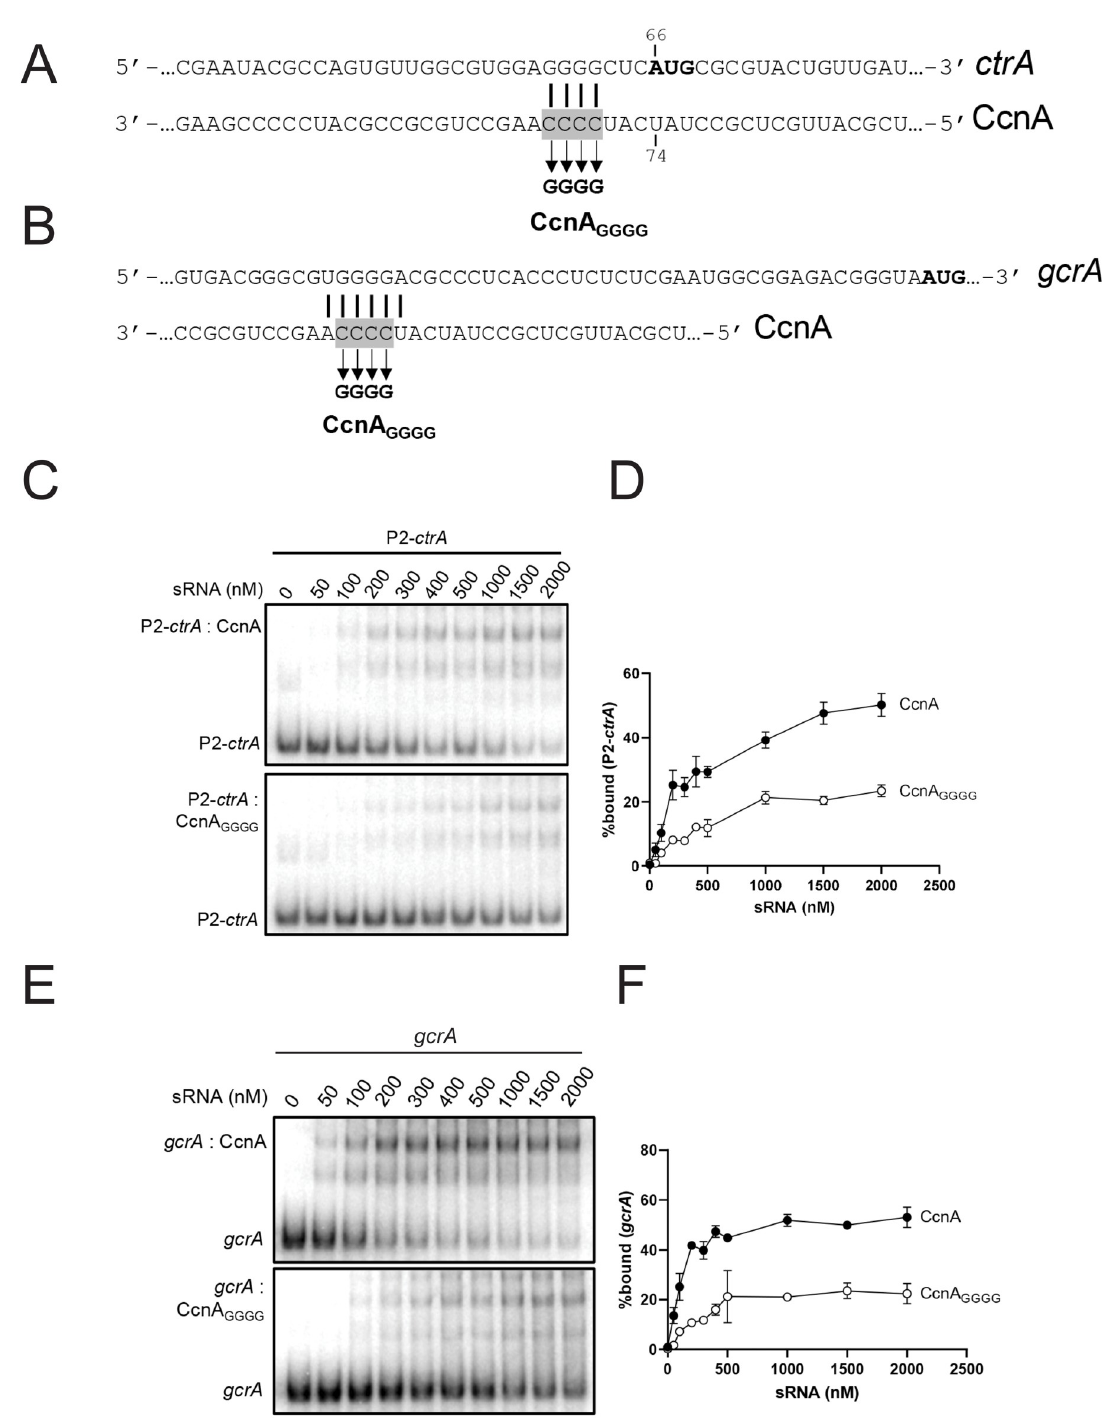
Fig 5. CcnA mutation of Loop A decreases the interaction with the 5 0 UTR of P2- ctrA mRNA and 5 0 UTR of gcrA mRNA. (A) Mutation of the ctrA mRNA ( ctrA ) and ncRNA CcnA (CcnA GGGG ) binding site (shown in red in Fig 4A). Solid lines indicate CcnA GGGG binding sites on ctrA . Boxed gray text corresponds to the nucleotides mutated. The translation start codon is shown in bold. ( B) Mutation of the gcrA mRNA ( gcrA GGGG ) and ncRNA CcnA (CcnA GGGG ) binding site (shown in red in Fig 4B). Solid lines indicate CcnA binding sites on gcrA . Boxed gray text corresponds to the nucleotides mutated. ( C) A final concentration of 5 nM of P2- ctrA (+143 nt from the P2- ctrA promoter) RNA fragment was incubated with increasing concentration of CcnA (top) or CcnA GGGG (bottom) ncRNA. % bound RNA with ncRNA CcnA (black) or CcnA GGGG (white) is showed ( D ). Data represent the mean of 2